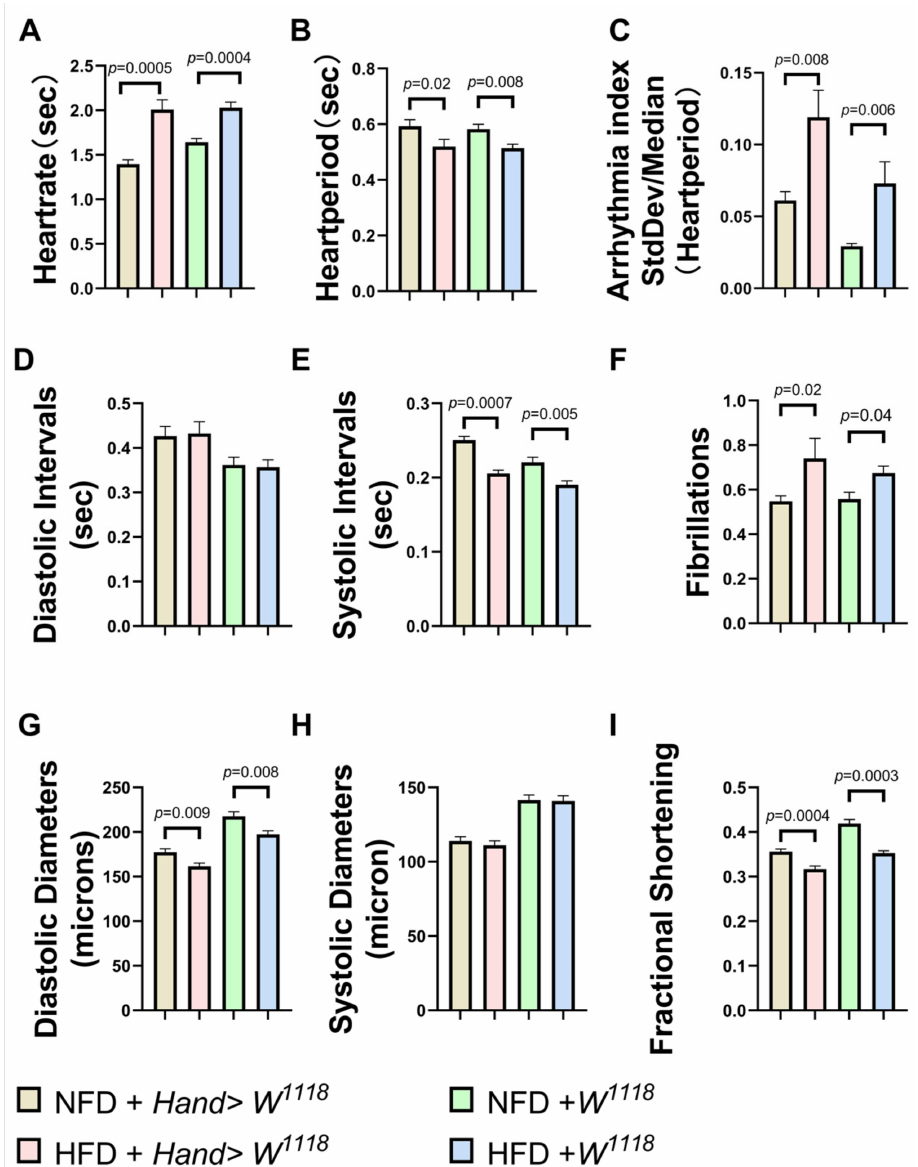
Figure 3. NFD and HFD groups of 10-day-old Drosophila M-mode ECG, with quantitative analysis of HR, HP, AI, DI, SI, FL, SD, DD, FS. Compared to NFD, w 1118 and Hand > w 1118 under HFD conditions, HR, AI and FL ( A , C , F ) were significantly upregulated. Moreover, HP, SI, DD and FS ( B , E , G , I ) decreased significantly, while DI and SD ( D , H ) did not show significant differences. All Drosophila were virgin flies, and the sample sizes for the two groups of NFD and HFD were N = 28 and N = 30, respectively. All p values were from independent samples t